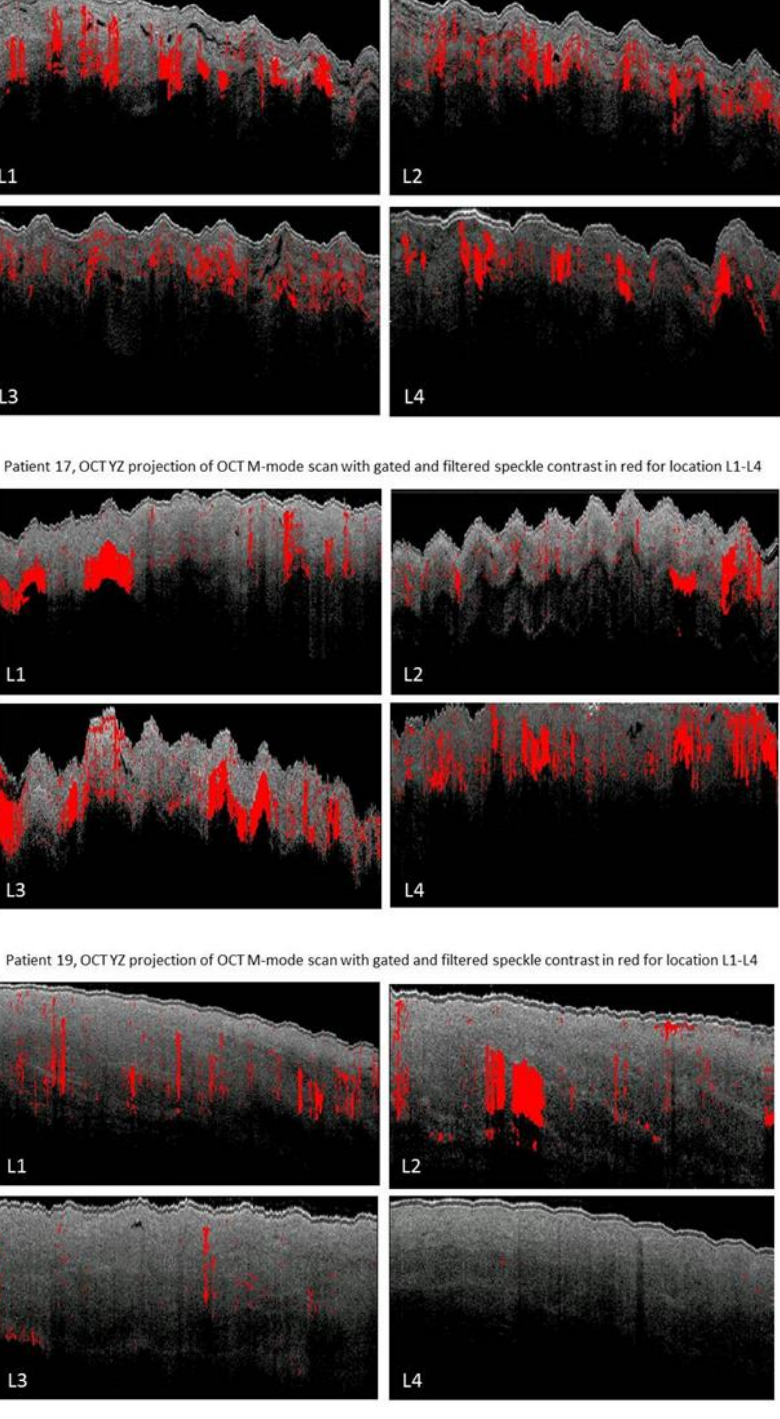
Figure 9. OCT speckle contrast indicative of flow overlaid with OCT grayscale (YZ) images from M-mode scans from location 1 (L1, 3 cm below the watershed), location 2 (L2, watershed), location 3 (L3, 3 cm above the watershed), location 4 (L4, fundus). In patient 9 high speckle contrast indicative of flow is seen in location 2 on the watershed area. In patient 14 and 19 a decreased speckle contrast indicative of flow is observed towards location 4. In patient 17 an increase in speckle contrast indicative of flow from location 1 to 4 is observed.